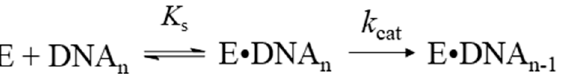
Scheme 1. The kinetic scheme of the formation of a complex of Apn2 with a DNA substrate followed by a stage of cleavage of a single nucleotide, where E: enzyme; DNA n : a 17–mer DNA duplex; and DNA n − 1 : an S–1 16–mer DNA duplex formed by the removal of the 3 ′ –terminal nucleotide. Table 1. K s and k cat values corresponding to the interaction of Apn2 with DNA duplexes. DNA